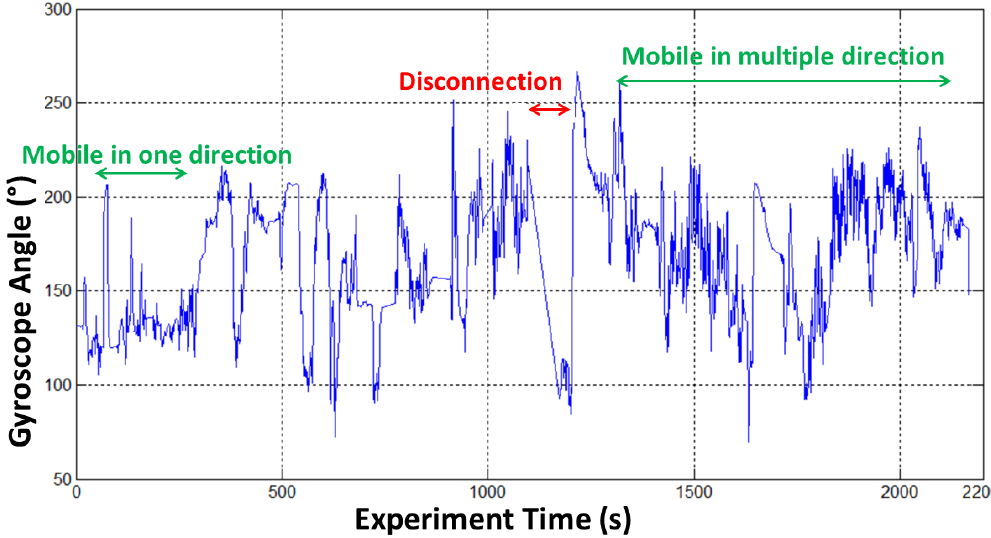
Figure 10. Gyroscope angle variation over 2200 s of the